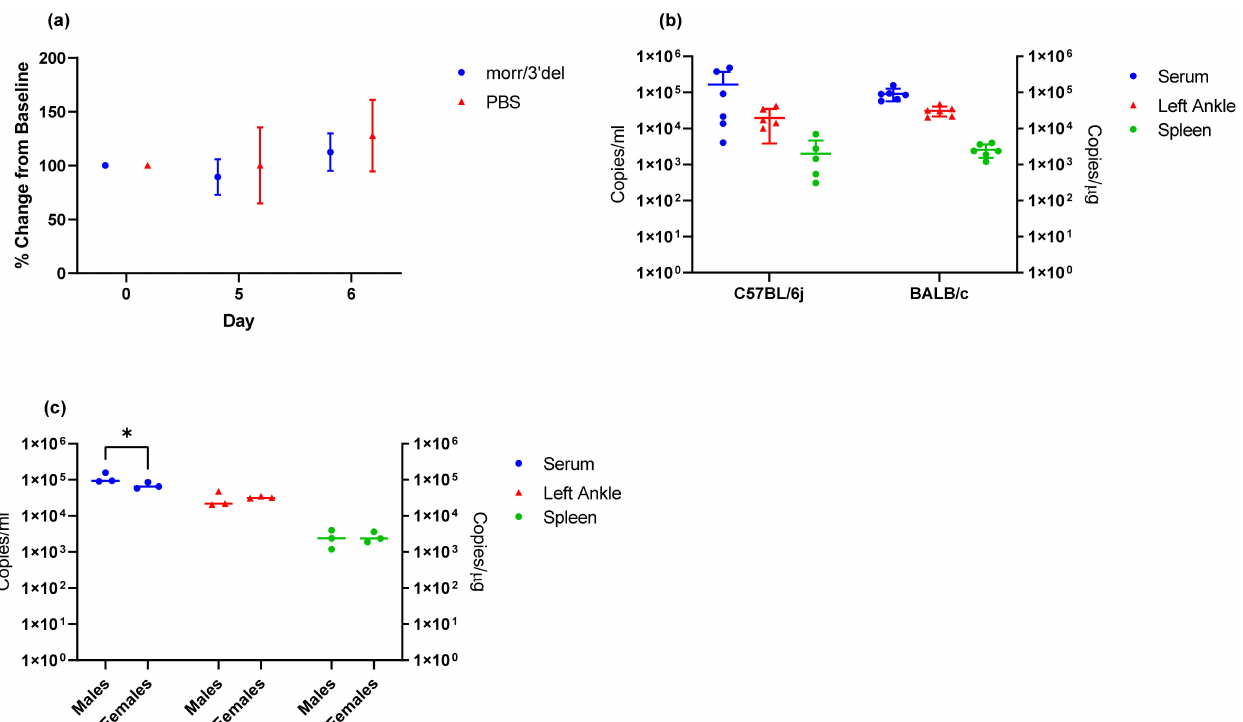
Figure 7. Clinical endpoints in aged BALB/c mice challenged with CHIKV morr/3 (cid:48) del at 1 × 10 4 copies. ( a ) Percent change in the left ankle on days 5 and 6 following challenge. ( b ) Viral RNA copy number in serum collected on day 3, left ankle collected on day 9, and spleen collected on day 9 in C57BL/6J mice versus BALB/c mice. ( c ) Viral RNA copy numbers in serum and tissues of male versus female BALB/c mice. Values are expressed as copies/mL for serum and copies/ µ g RNA for tissues. * p <